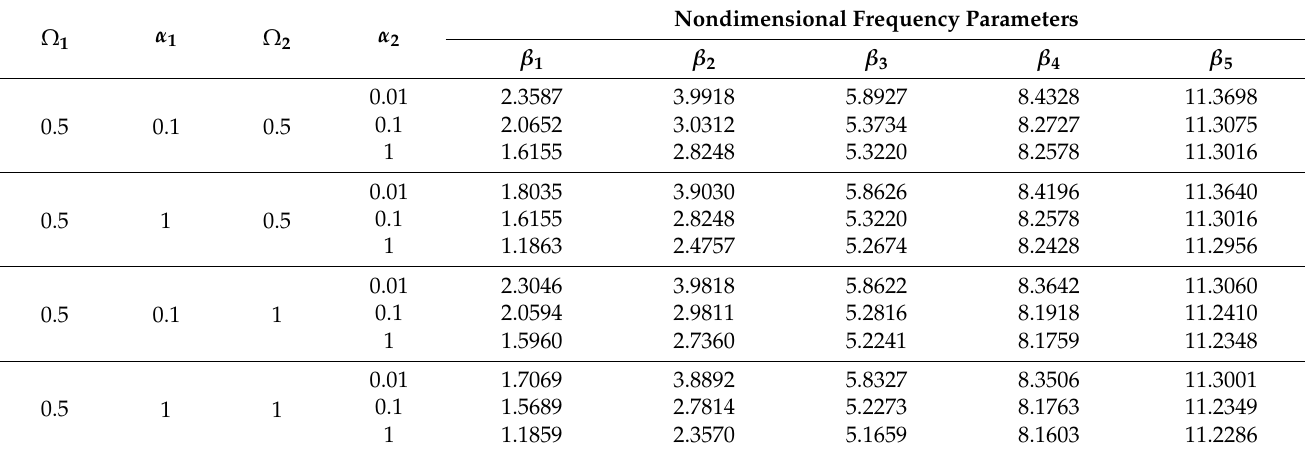
Table 2. The first five nondimensional frequency parameters for different values of Ω 1 , α 1 , Ω 2 , α 2